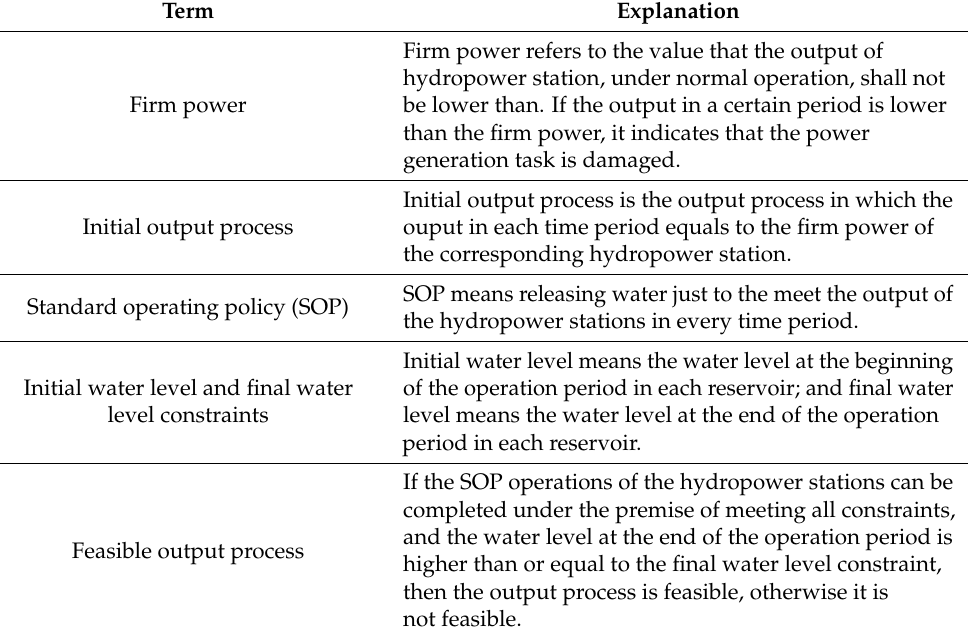
Table 1. Table of